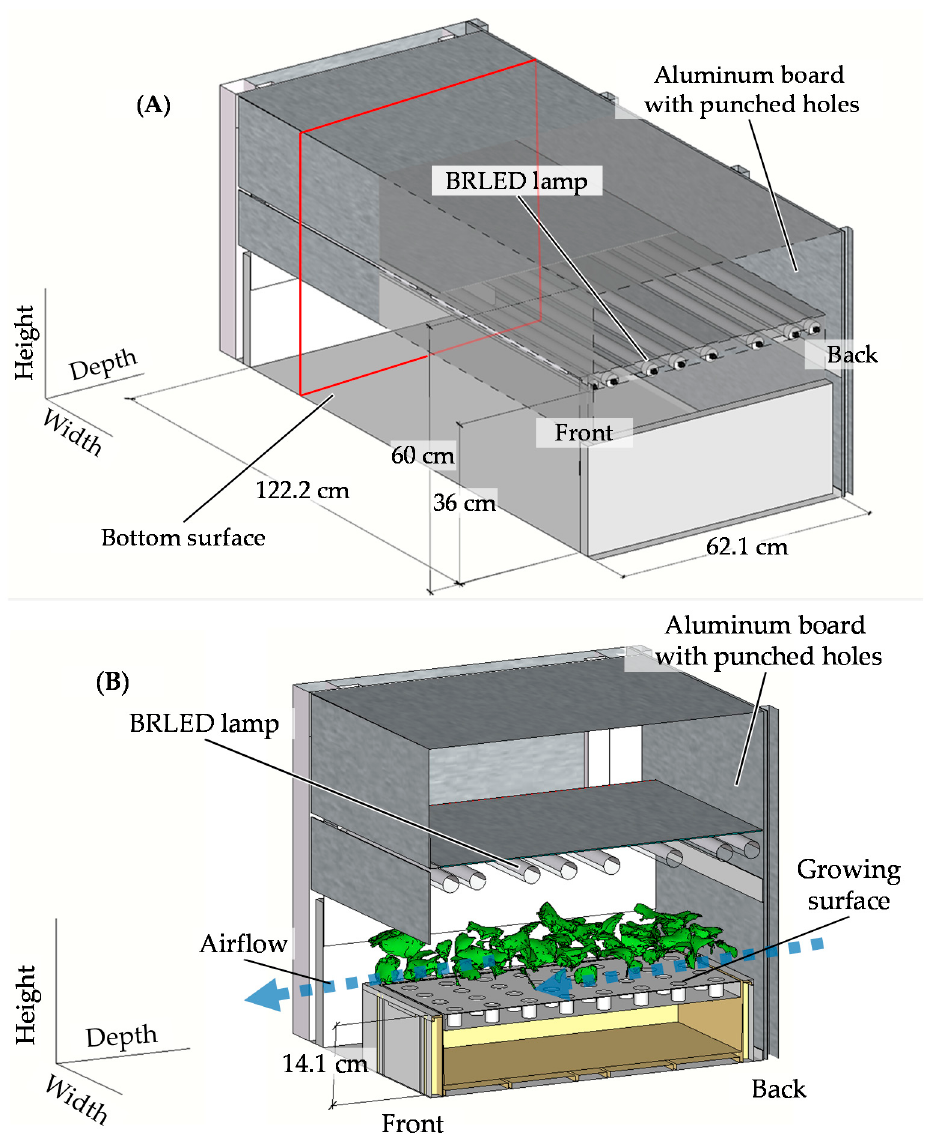
Figure 2. The 3D model of a cultivation shelf ( A ) and the cross-section view ( B ) along the red lines in ( A ). This model was made by SketchUp 2017 (Trimble Inc., Sunnyvale, CA, USA). The size of the cultivation shelf is 122.2 cm in width, 62.1 cm in depth, and 60.0 cm in height. In this figure, eight BRLED lamps are placed at 36.0 cm in height. All surfaces except for the back surface were covered with the reflection sheets (FEB#110, Yupo Corporation, Tokyo, Japan) with a reflectance of approximately 91%. The back surface was an aluminum board with numerous punched holes for ventilation.